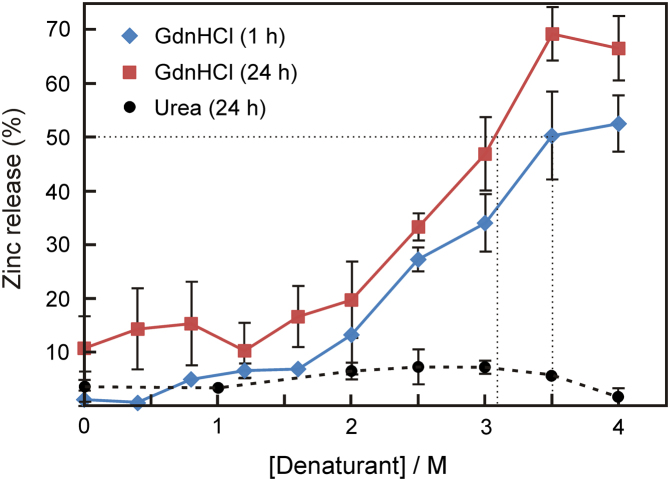
Influence of denaturants on the dissociation of Zn2+ from LF. LF (5 μM) in Hepes buffer (50 mM, pH 7.4) was incubated in the absence and presence of GdnHCl or urea at the concentrations indicated in the figure for 1 h (blue diamonds for GdnHCl) and 24 h (red squares for GdnHCl; black circles for urea) at room temperature prior to recovery of released Zn2+ by Amicon filtration. The concentration of Zn2+ in the filtrate was quantified spectrophotometrically (at 500 nm) with the aid of PAR. Values shown are based on the release of all LF-bound Zn2+ ions (i.e., 5 μM) taken as 100%, and depict the mean (±1 s.d.) of three independent experiments. The dotted lines depict the concentrations of GdnHCl at which the midpoints of Zn2+ release (50% value) were achieved.